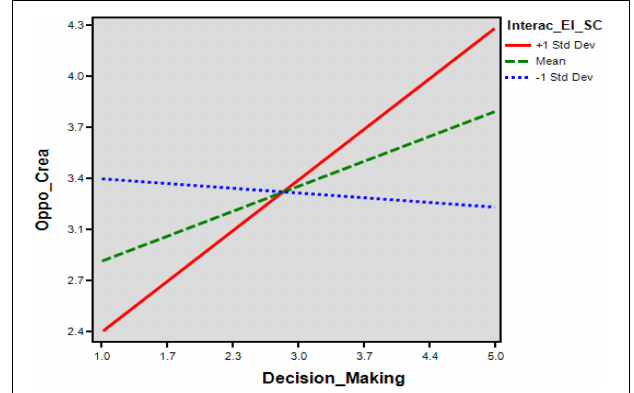
FIGURE 5 | Three-way interaction on opportunity